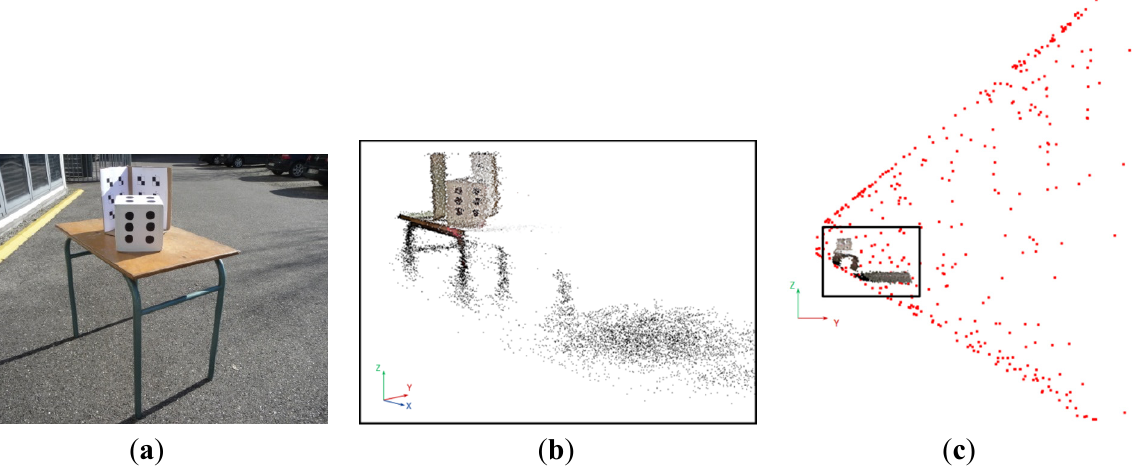
Figure 5. Outdoor acquisitions: ( a ) Picture of the observed scene; ( b ) Corresponding point cloud acquired with the sensor, ( c ) and the same entire point cloud in a profile view (scene in a black rectangle) without removal of the “flying pixels”